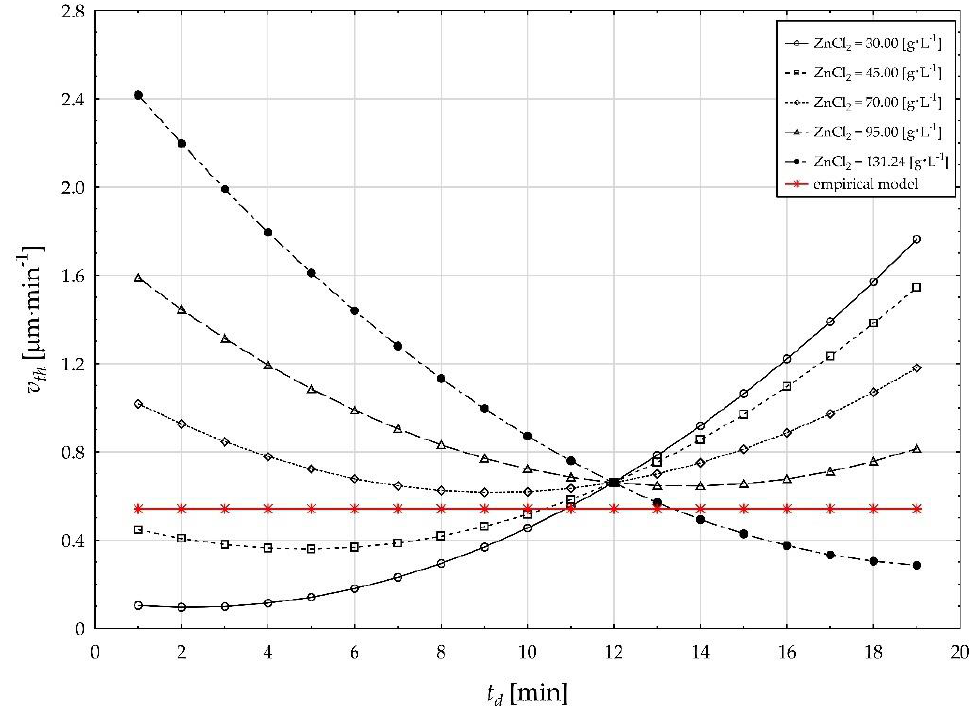
Figure 3. The graphical presentation of dependences in the speed of zinc coating growth on the time of deposition at defined amount of zinc chloride in the electrolyte. of deposition at defined amount of zinc chloride in the